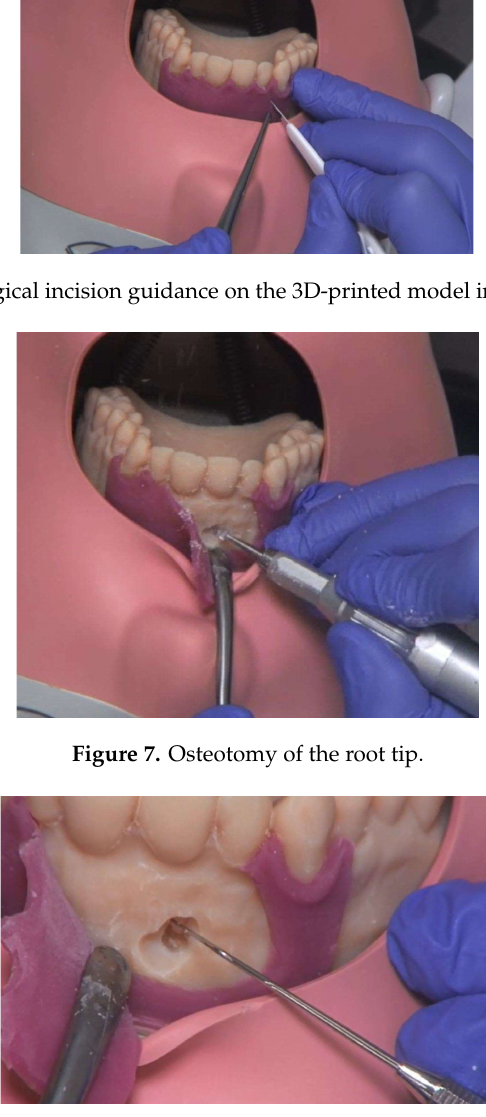
Figure 8. Presentation of the root tip. Note: torn gingiva mask.